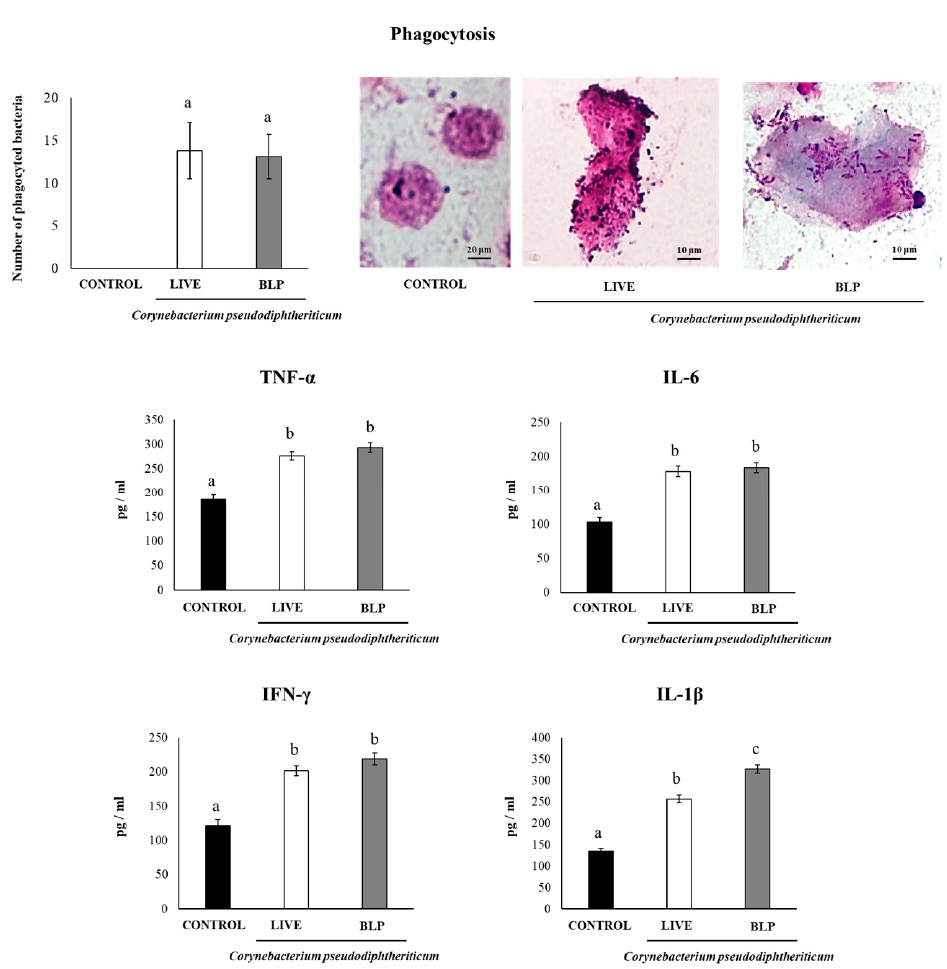
Figure 2. Interaction of Corynebacterium pseudodiphtheriticum 090104 and its bacterium-like particles (BLPs) with murine alveolar macrophages. Phagocytosis of C. pseudodiphtheriticum and its BLPs by murine alveolar macrophages was evaluated by microscopic analysis. The production of TNF- α , IL-1 β , IL-6, and IFN- γ in the culture supernatants of alveolar macrophages stimulated with bacteria or BLPs was evaluated after 24 h. Untreated murine alveolar macrophages were used as controls. Results represent data from three independent experiments ( n = 12) and are expressed as mean ± standard deviation. Letters indicate significant differences between the groups ( p <